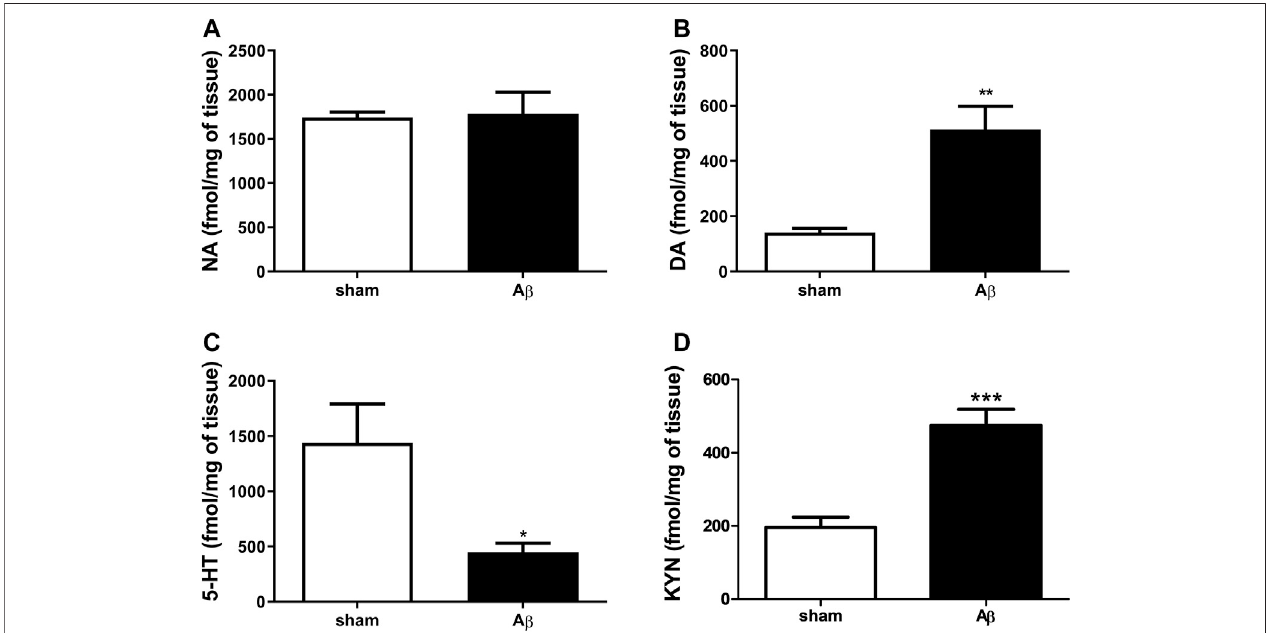
FIGURE3| EffectsofA β administrationonhypothalamicNA,DAand5-HTlevels. (A) NA(fmol/mgoftissue)insham(n (cid:1) 5)andA β -treated(n (cid:1) 6)animals.Unpaired Student ’ st-test, p > 0.05. (B) DA (fmol/mg oftissue) insham (n (cid:1) 5)and A β -treated (n (cid:1) 6) animals. Unpaired Student ’ st-test, ** p < 0.01A β vs sham. (C) 5-HT (fmol/mg oftissue)insham(n (cid:1) 6)andA β -treated (n (cid:1) 6)animals.UnpairedStudent ’ st-test,* p < 0.05A β vssham. (D) KYN(fmol/ μ l)insham(n (cid:1) 5)andA β -treated (n (cid:1) 5)animals. Unpaired Student ’ s t-test, *** p < 0.001 A β vs sham.